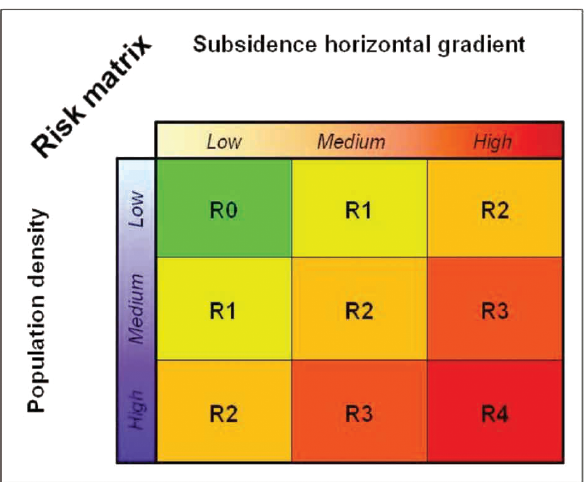
Figure 3. Risk matrix used to produce the hazard zonation map shown on Fig. 4, relating subsidence gradient and population density.